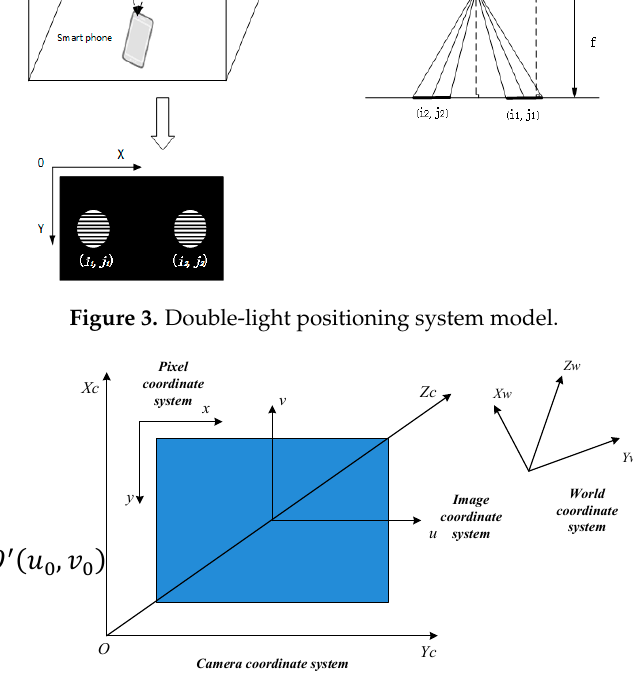
Figure 4. ( x , y ) is the pixel coordinate system, ( u , v ) is the Image coordinate system, ( X c , Y c ) is the Camera coordinate system and ( X w , Y w , Z w ) is the world coordinate system.